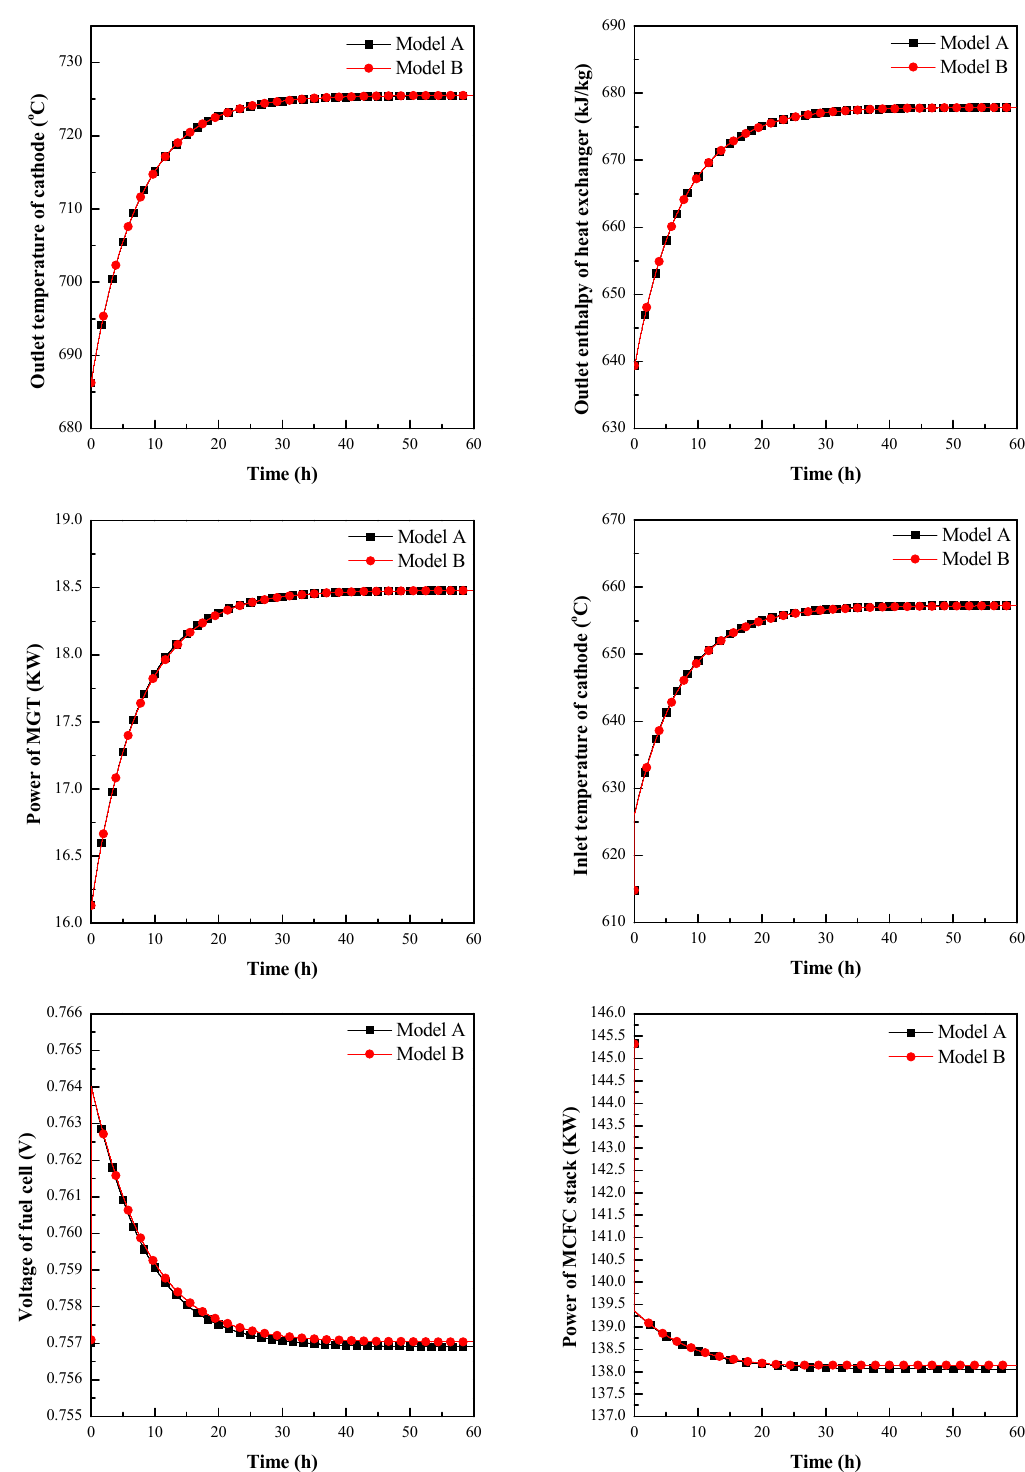
Figure 8. The step-down of the MCFC current density—comparison of the slow time scale transient responses of the outlet temperature of the cathode, the outlet enthalpy of the heat exchanger, the power of the MGT, the inlet temperature of the cathode, the voltage of the fuel cell, and the power of the MCFC stack between the MCFC-MGT model and the MCFC-MGT model based on the Sim–Stim interface model.